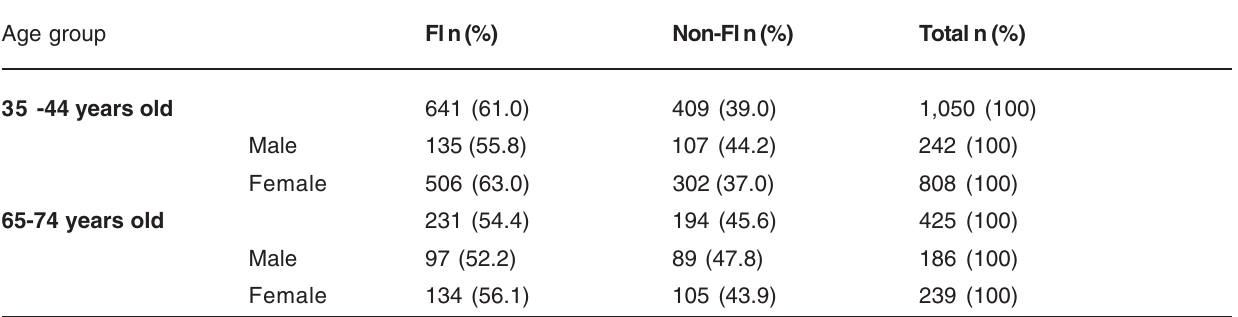
TABLE 1- Dentate individuals according to fluoridated (Fl) and non-fluoridated (Non-FL) water, age group and gender. Southeast Region of São Paulo State, Age group